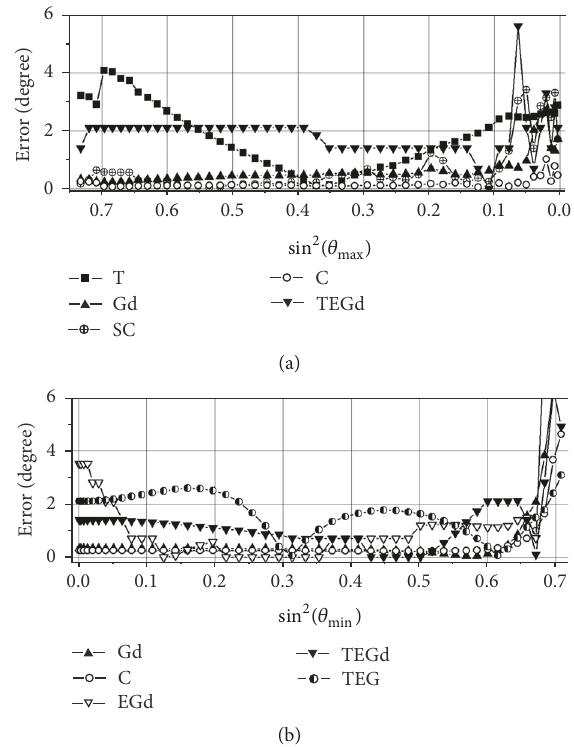
Figure 9: Techniques of higher quality, variant 𝑉 𝑃3 = 3200 : (a) the fixed minimum offset and (b) the fixed maximum